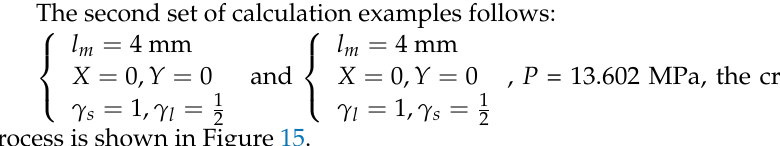
(cid:2869) , ( b ) 𝛾 (cid:3039) = 1 ， 𝛾 (cid:3046) = Figure 14. First set of simulation models: l m = 3 mm, X = 0, Y = 1. ( a ) γ s = 1, γ l = 1 2 , ( b ) γ l = 1, γ s = 1 2 . (cid:2870)